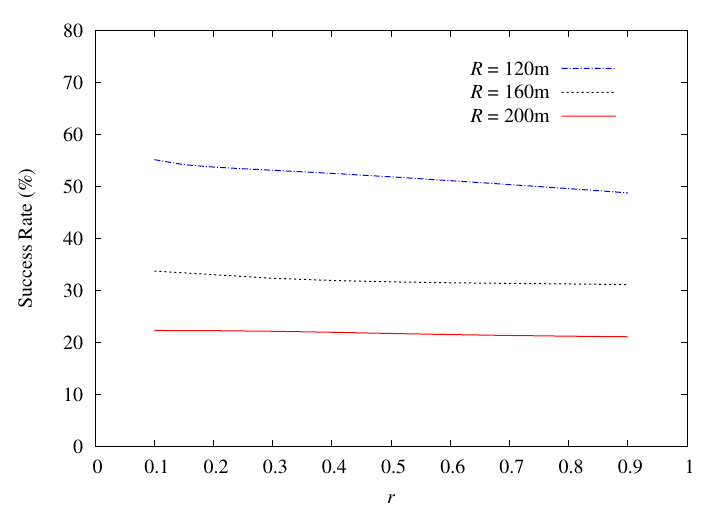
Figure 9. Impact of the ratio d 2 / R 2 on discovery success rate ( d = 100